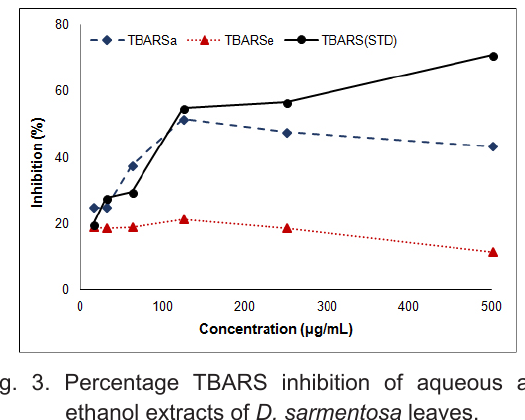
Fig. 3. Percentage TBARS inhibition of aqueous and ethanol extracts of D. sarmentosa leaves.